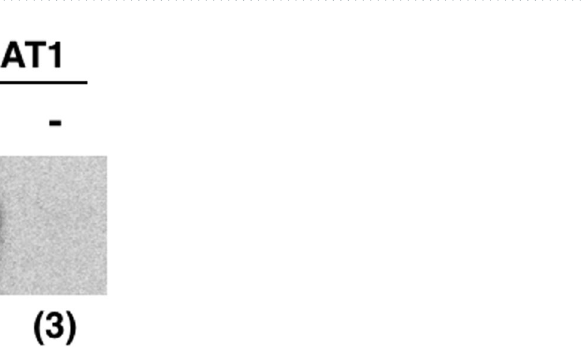
Figure 4. Inhibition of SOAT1 and SOAT2 by BeauIII in an enzyme-based assay using an intact ER fraction from SOAT1- and SOAT2-CHO cells sonicated for 3 min. Each cell lysate in SOAT1-/SOAT2-CHO cells sonicated for 3 min was fractionated in 10 fractions with the Optiprep TM density gradient. In order to identify the ER fraction including SOAT proteins, SOAT protein levels and activities were measured using a Western blotting analysis and SOAT assay, respectively ( A and B ). The SOAT-rich ER fraction was then used as an enzyme source for the SOAT1 ( ● ) and SOAT2 ( ■ ) assays ( C ). The results obtained were plotted as % of control (without drugs). Values represent means ± SD (n = 3~4).